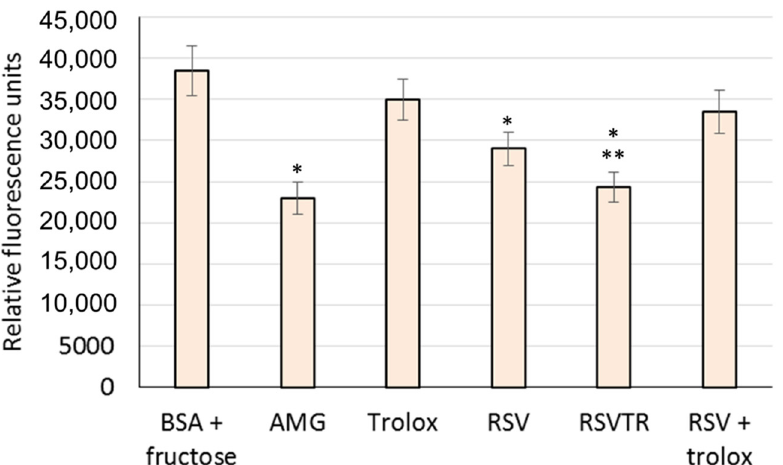
Figure 8. Relative fluorescence units of bovine serum albumin (BSA) incubated with fructose and in presence of aminoguanidine (AMG) as reference or in presence of trolox (positive control), resveratrol (RSV), resveratrol trimester with trolox (RSVTR) or a physical mixture of RSV and trolox in the same molar ratio of RSVTR (RSV + trolox). Statistical analysis for the comparison: * p < 0.05 vs. BSA + fructose; ** p < 0.05 vs. RSV.